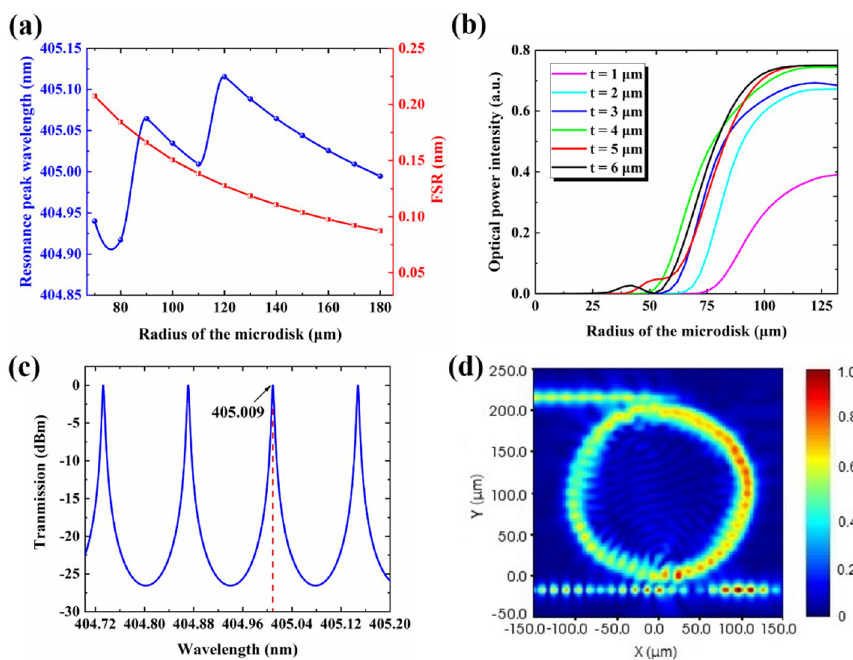
Fig. 4 Optical properties simulation analysis of the designed waveguide microdisk-based resonator. a The calculation results of resonance wavelength and FSR with different microdisk radii; b relationship between microdisk resonator radii and the optical power intensity with different waveguide core layer thickness; c the optical transmission spectrum of the microdisk-based resonator; d optical transmission simulation of the waveguide microdisk